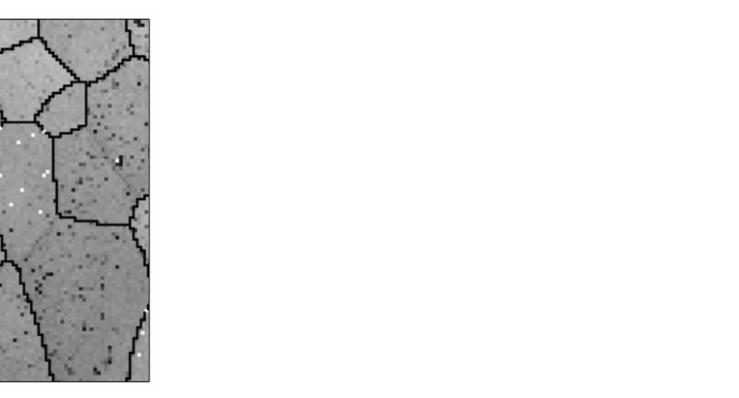
Figure 2. Original microstructures of the researched alloy (OIM image is indicated in a previous study